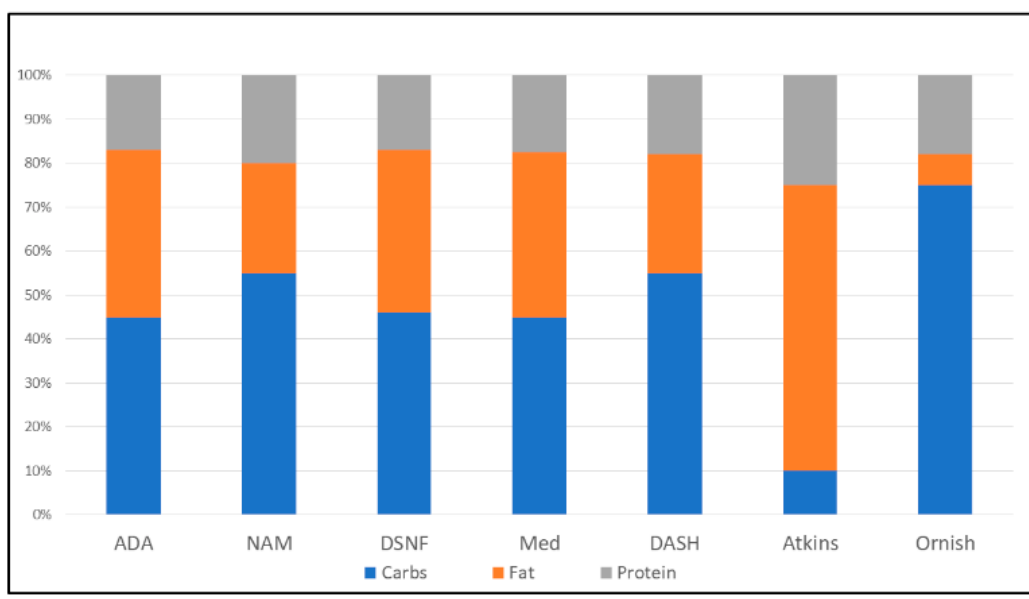
Figure 1. Macronutrient distributions in contemporary eating patterns, diabetes-specific nutrition formulas, and popular diets.